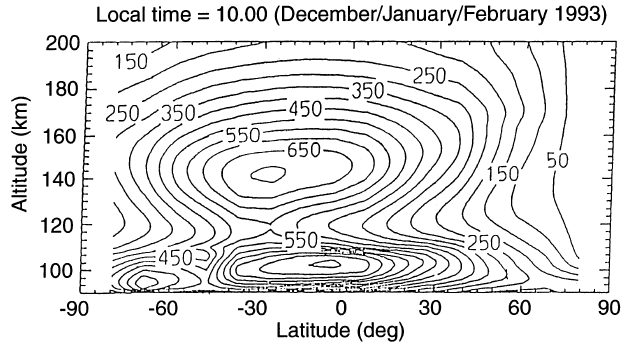
Fig. 5. The latitudinal variation of three monthly (December 1992/ January/February 1993) averaged volume emission rates as measured by wind imaging interferometer (WINDII) at 10 h local time (courtesy of Prof. G. G. Shepherd, York University, Canada)